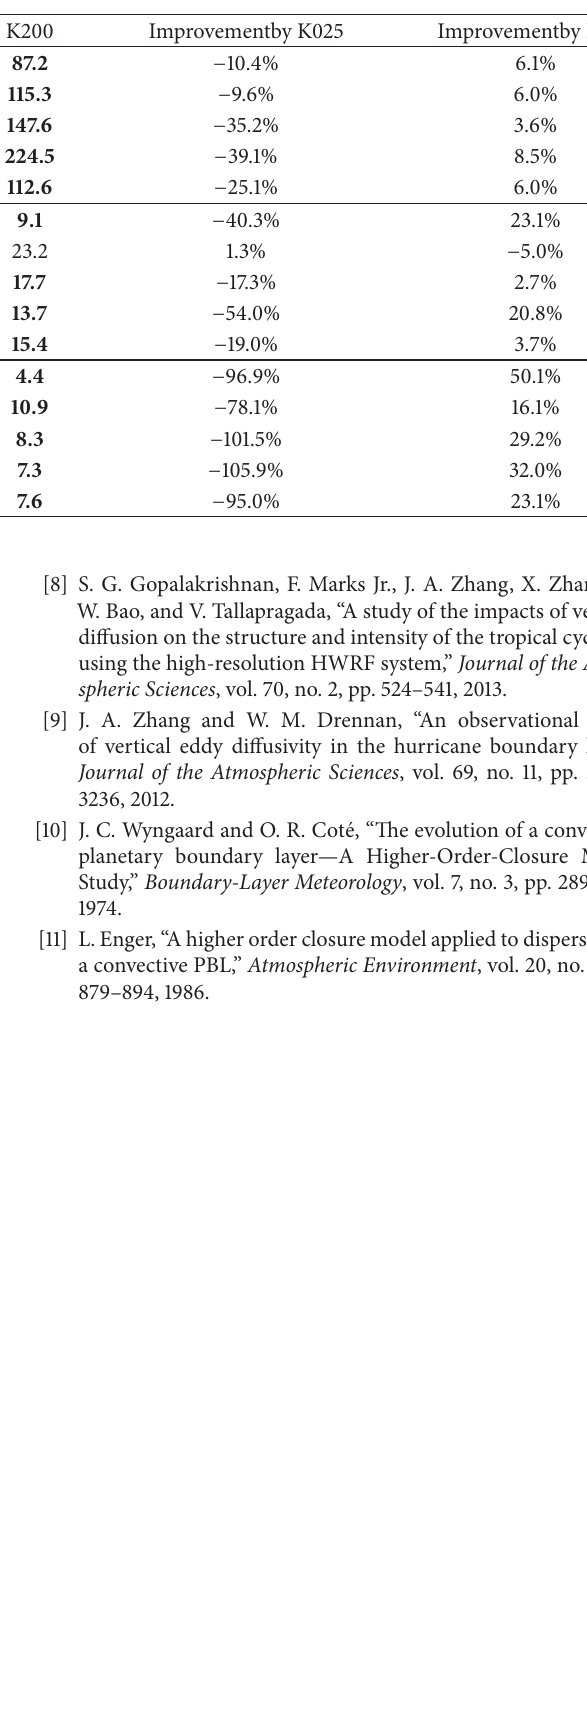
Table 9: Averaged AEs and MAEs of track, CSLP, and MWSP simulated by the original YSU, the K025, and the